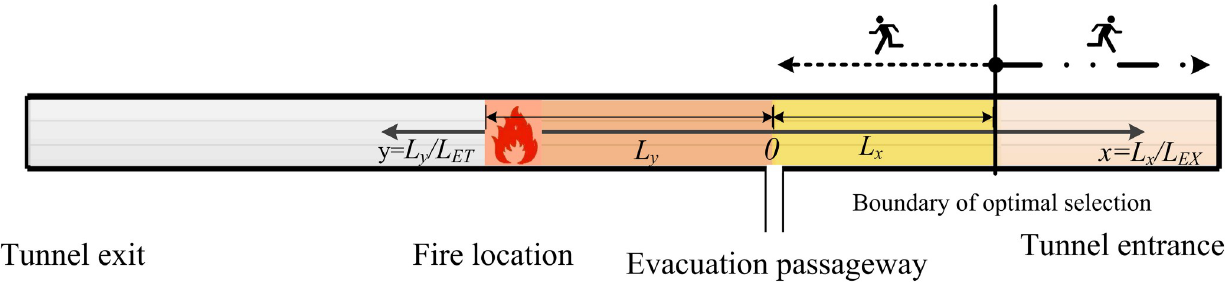
Fig 2. Mathematical model of occupants evacuating in the highway